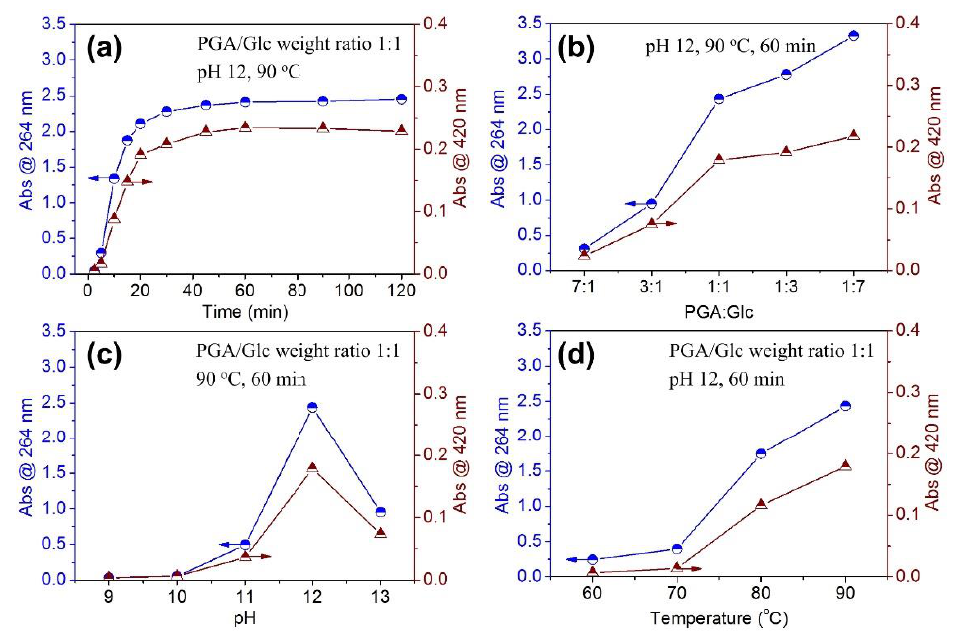
Figure 1. Dependence of the absorbance at 264 and 420 nm of the PGA/Glc reaction products on reaction time ( a ), weight ratio of PGA to Glc ( b ), pH ( c ), and temperature ( d ) in the presence of 0.8 g/100 mL PGA+Glc.